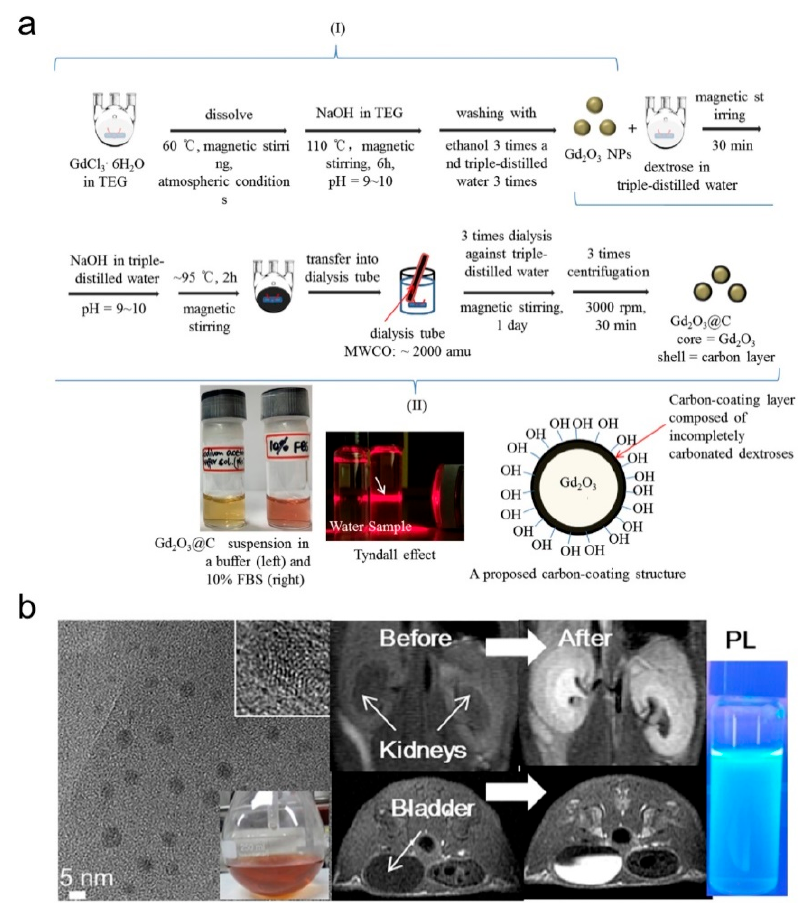
Figure 7. ( a ) Two-step synthesis of Gd 2 O 3 @C: (i) the synthesis of Gd 2 O 3 NDs in triethylene glycol (TEG), and (ii) carbon coating on the Gd 2 O 3 ND surfaces in aqueous solution. From left to right at the bottom of ( a ), photographs of the Gd 2 O 3 @C in sodium acetate buffer solution (pH = 7.0) and a 10% FBS in RPMI1640 medium, the Tyndall effect (or laser light scattering) as indicated with an arrow in the Gd 2 O 3 @C in water sample (right) with no light scattering in the reference triple-distilled water (left), and a proposed carbon-coating structure of Gd 2 O 3 @C. ( b ) High resolution transmission electron microscope (HRTEM) micrograph of Gd 2 O 3 @C, photograph of Gd 2 O 3 @C in water, in vivo MRI of mouse before or after intravenously administrated by Gd 2 O 3 @C and PL of Gd 2 O 3 @C at a dose